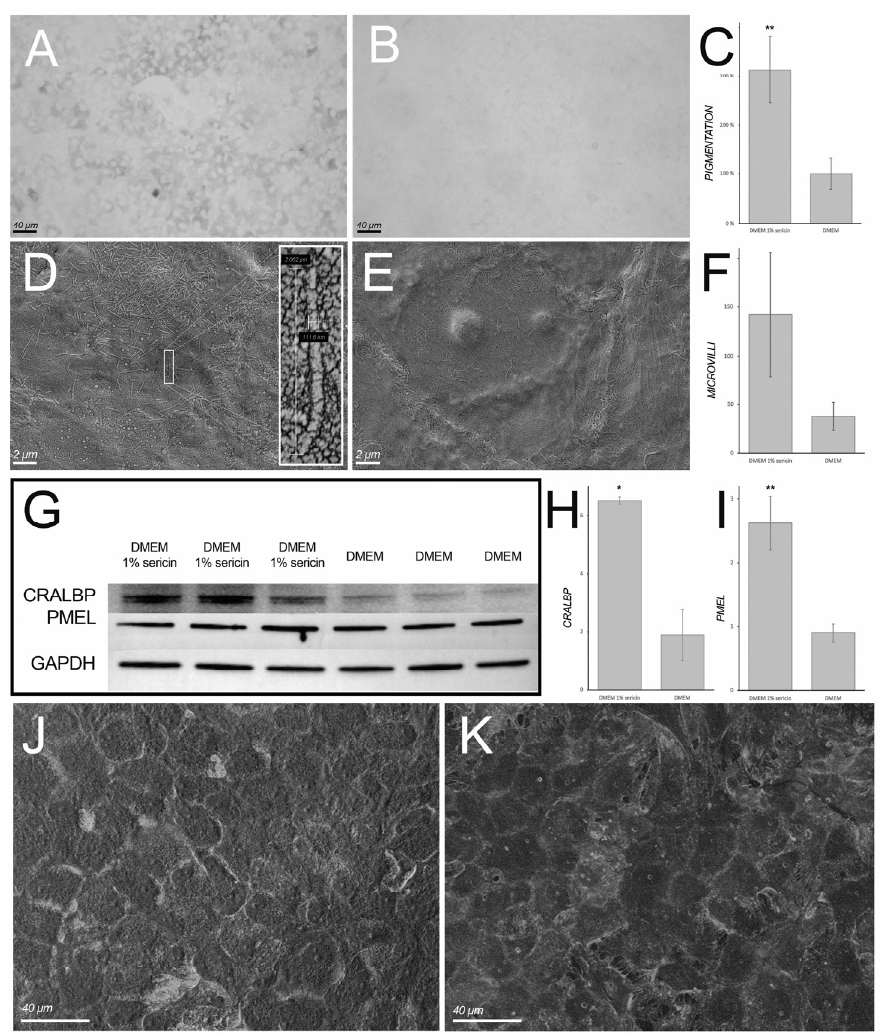
Figure 6. Light microscopy images (grayscale) of RPE cultured in Dulbecco’s Modified Eagle’s Medium (DMEM) with ( A ) or without ( B ) 1% sericin in which the former group contained significantly more pigmented cells. The bar chart ( C ) shows culture well area covered by pigmented cells normalized to control cultures (RPE cultured in DMEM only; set to 100%). In RPE cultured in DMEM with 1% sericin ( D ), apical microvilli appeared to be more abundant in comparison to cells cultured in DMEM only ( E ). However, the di ff erence was not statistically significant (F). The bar chart shows mean number of microvilli in 10 µ m × 10 µ m sections of SEM micrographs counted independently by three blinded investigators ( F ). To assess RPE-specific maturation markers, immunoblotting ( G ) was used to quantify cellular retinaldehyde-binding protein (CRALBP) and premelanosome protein (PMEL), which were both most abundant in the sericin-supplemented cultures. Glyceraldehyde 3-phosphate dehydrogenase (GAPDH) was used as loading control. The bar charts show relative expression of CRALBP / GAPDH ( H ) and relative expression of PMEL / GAPDH ( I ). Tightly adjoined, hexagonal cells with typical cobblestone morphology were observed in both groups ( J : DMEM with 1% sericin; K : DMEM only). All bar charts ( C , F , H , I ) show mean values ± standard deviation error bars. * p < 0.05. ** p <